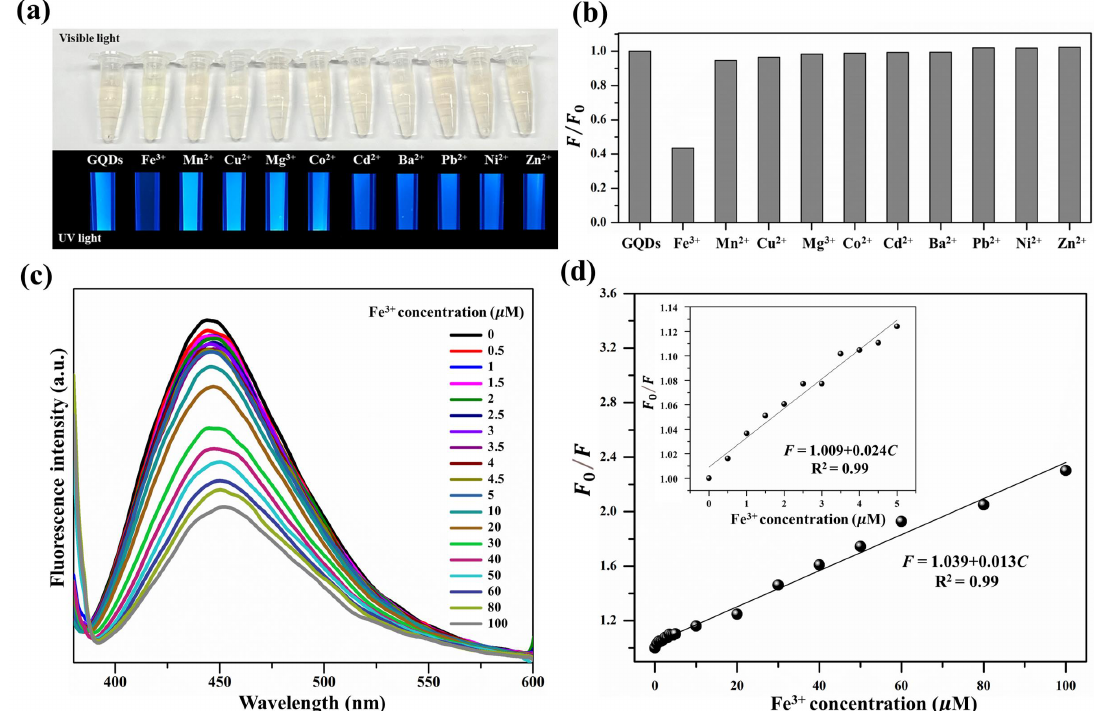
Figure 5. ( a ) PL response of GQDs with various metal ions under an excitation wavelength of 365 nm (top: under visible light; bottom: under UV light), ( b ) fluorescence intensity ratio ( F/F 0 ) of GQDs at 100 µ M of various metal ions, ( c ) PL intensity of GQDs with the addition of Fe 3 + in various concentrations, and ( d ) PL intensity of GQDs with different concentrations of Fe 3 + (0–100 µ M), the inset: the plot of the GQD PL intensity with low concentrations of Fe 3 + (0–5 µ